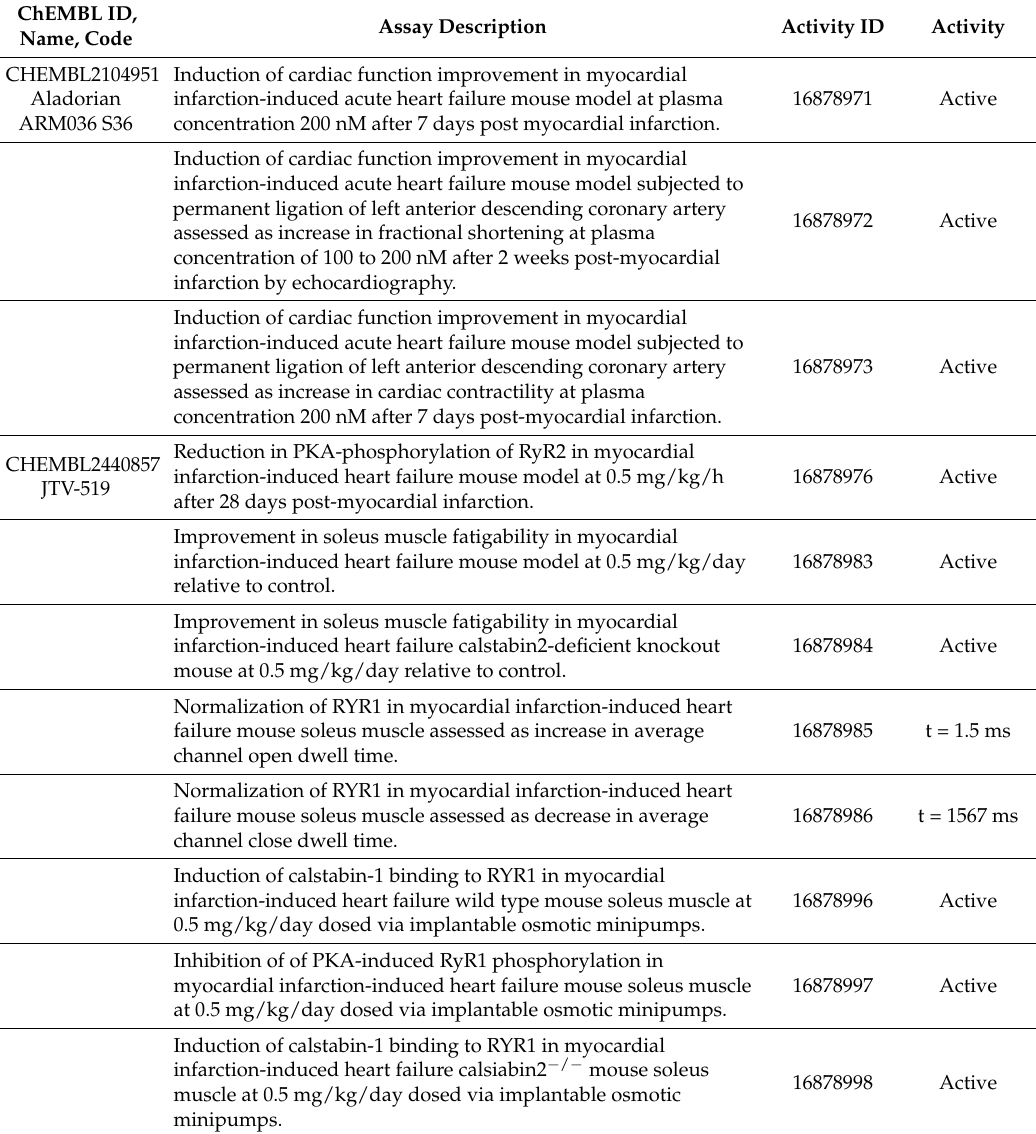
Table 3. Biological action of the compounds CHEMBL2104951 and CHEMBL2440857.